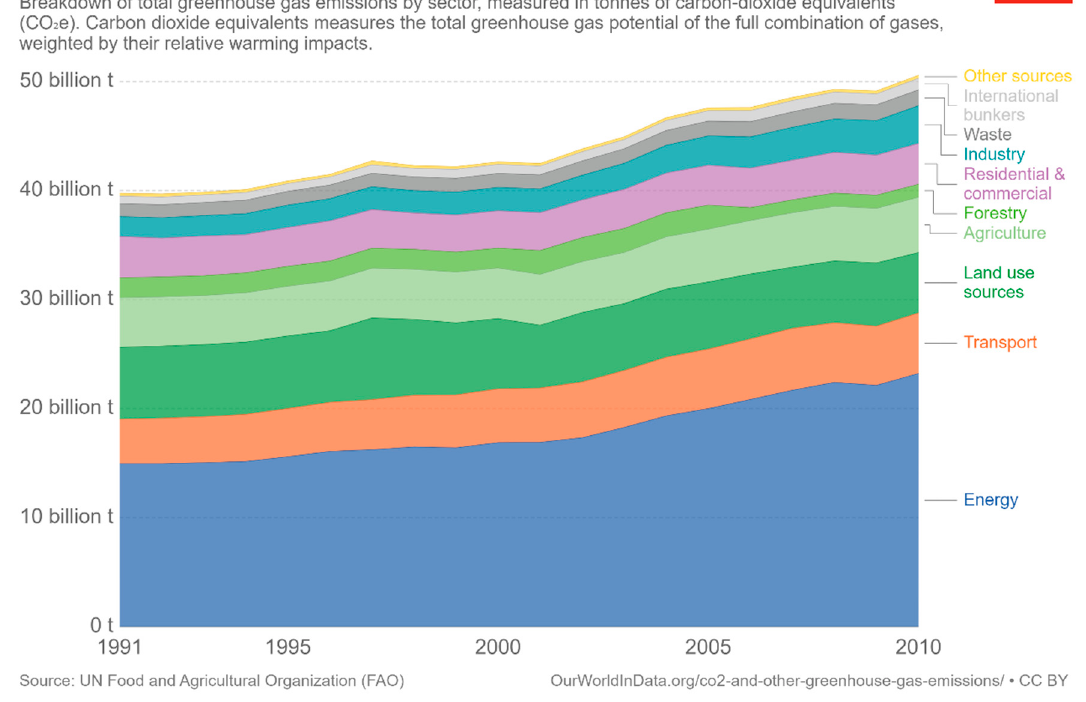
Figure 5. Breakdown of total greenhouse gas emissions by sector, measured in tons of carbon-dioxide equivalents [52].